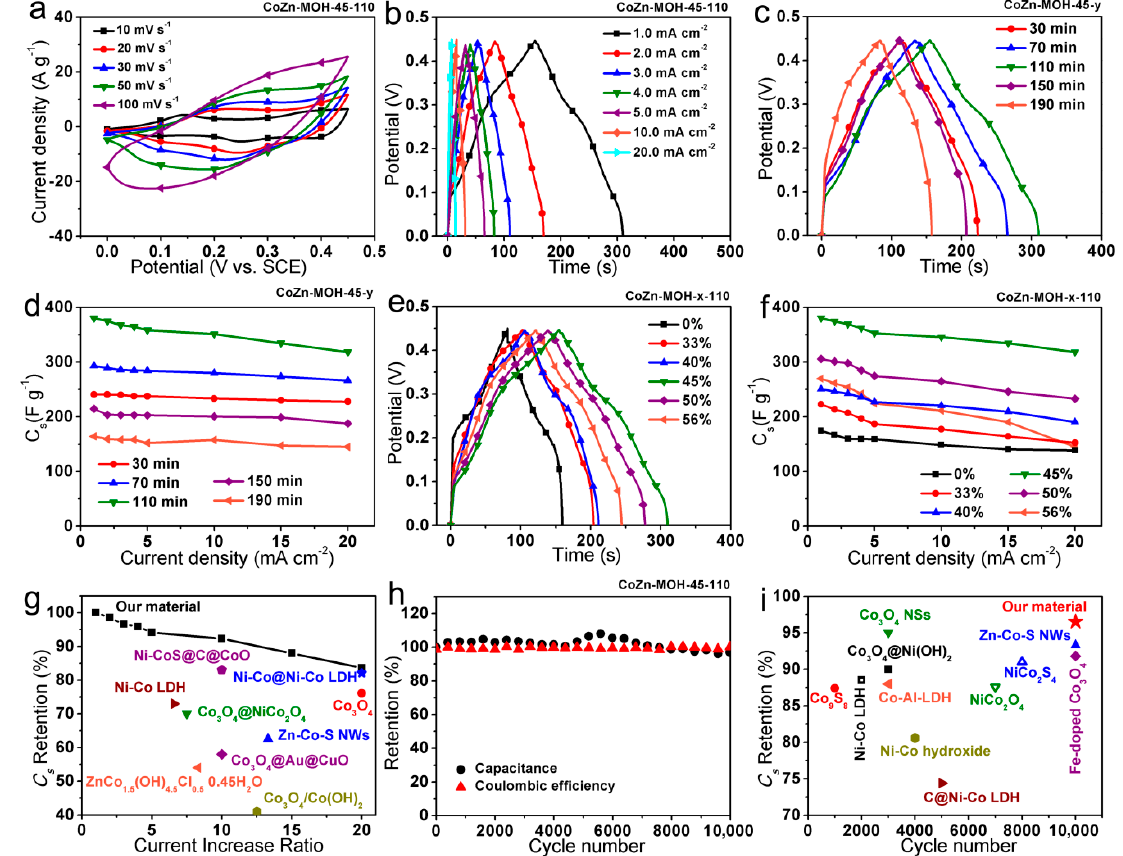
Figure 5. ( a ) Cyclic voltammetry (CV) curves, ( b ) charge–discharge (CD) curves, and ( h ) cycling performances of CoZn-MOH-45-110 electrode. Comparisons of ( c ) CD curves at 1 mA · cm − 2 and ( d ) specific capacitance ( C s ) of CoZn-MOH-45-y electrodes prepared with different times. Comparisons of ( e ) CD curves at 1 mA · cm − 2 and ( f ) C s of CoZn-MOH-x-110 electrodes prepared with different feeding molar percentages of zinc ion. Comparisons of ( g ) rate capabilities and ( i ) cycling performances of our CoZn-MOH-45-110 electrode and similar electrodes.